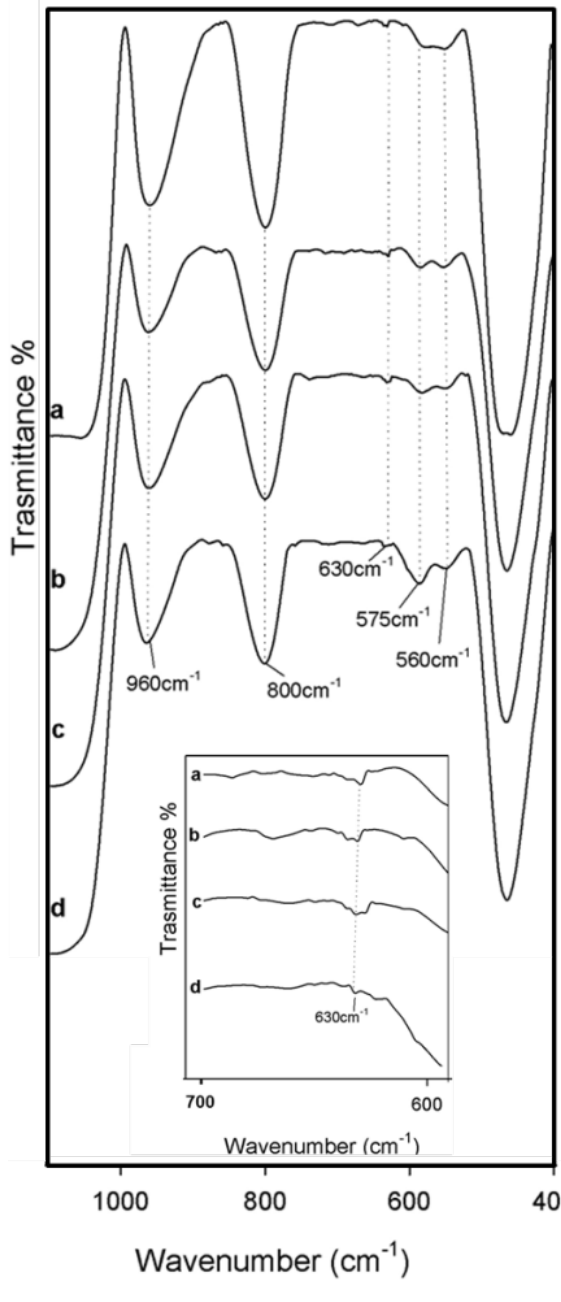
Figure 6. Representative FTIR spectra of ( a ) SiO 2 /PEG 50 wt % /CGA 5 wt % ; ( b ) SiO 2 /PEG 50 wt % /CGA 10 wt % ; ( c ) SiO 2 /PEG 50 wt % /CGA 15 wt % ; ( d ) SiO 2 /PEG 50 wt % /CGA 20 wt % after 21 days of exposure to SBF.